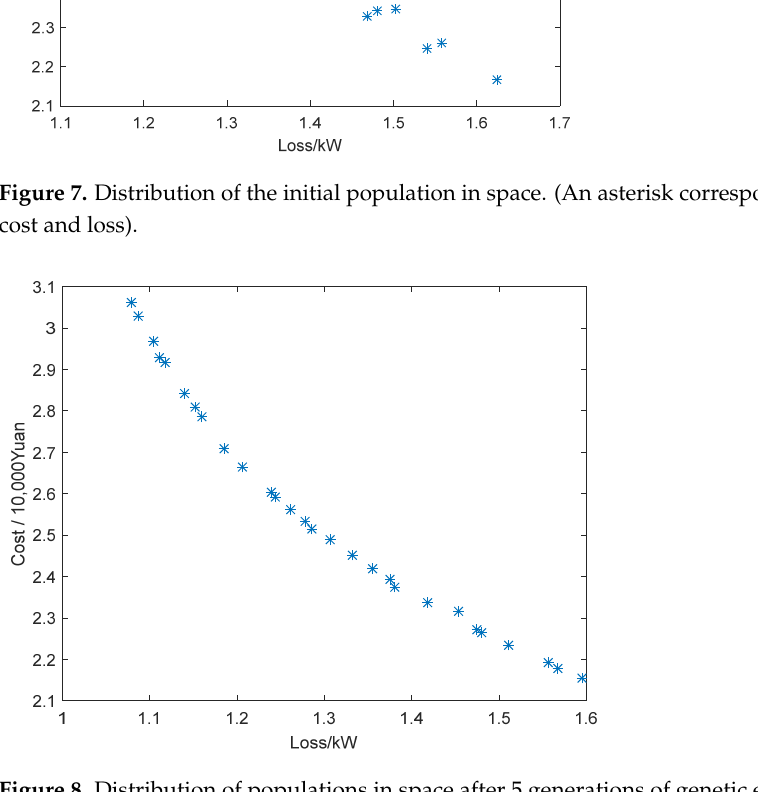
Figure 8. Distribution of populations in space after 5 generations of genetic evolution. (An asterisk corresponds to an individual's cost and loss.)